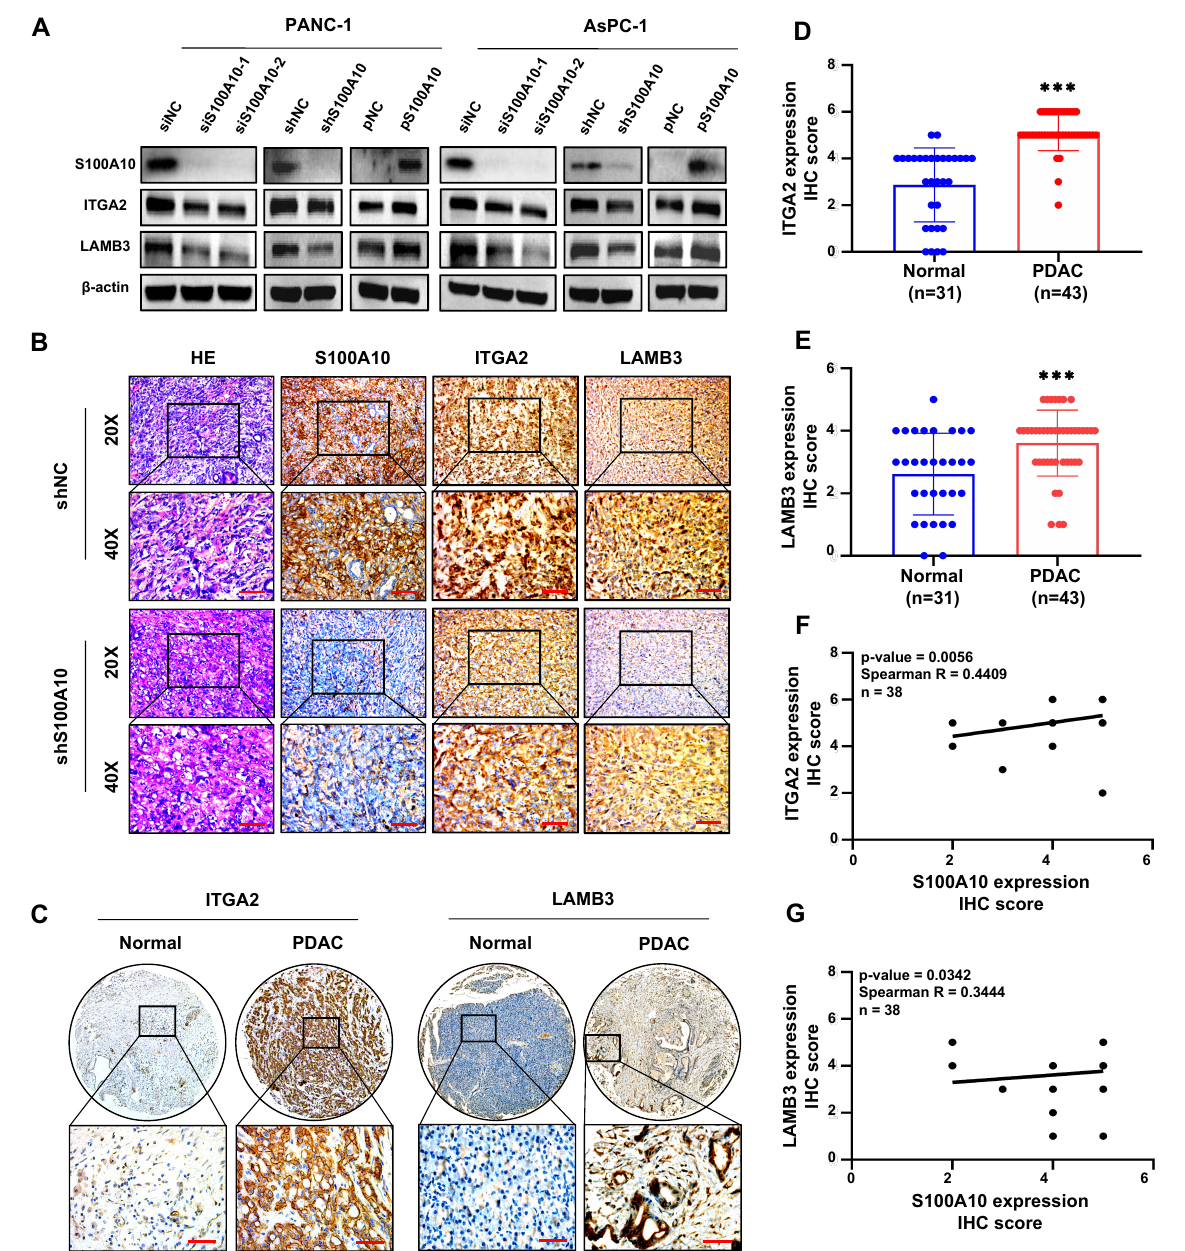
Figure 5. ITGA2 and LAMB3 are proved to be activated by S100A10 in PDAC. ( A ) After transfection with siRNAs against S100A10 (siS100A10-1, siS100A10-2) or control siRNA (siNC), a plasmid to over- express S100A10 (pS100A10) or control plasmid (pNC) for 72 h, western blotting was used to measure the expression of indicated proteins in the siNC, siS100A10-1, siS100A10-2, pNC, pS100A10, S100A10 stably knocked-down (shS100A10) or control (shNC) PANC-1 and AsPC-1 cells. The transfection concentrations of siRNAs and plasmids were 100 nM and 2.5 ng/uL, respectively. ( B ) HE stain and IHC stain of S100A10/ITGA2/LAMB3 in the control (shNC) and S100A10 stably knocked- down (shS100A10) PANC-1 cells pancreatic tumor tissues from orthotopic xenograft mice. Scale bar: 50 um. ( C – E ) IHC stain of ITGA2/LAMB3 in human PDAC tissues and pancreatic non-tumor tissues (*** p < 0.001 by Mann–Whitney test). Scale bar: 50 um. ( F , G ) The spearman correlation analyses between S100A10 and LAMB3/ITGA2 in human PDAC tissues (cutoff of p -value: 0.05). Whole western blot images are showed in Figure